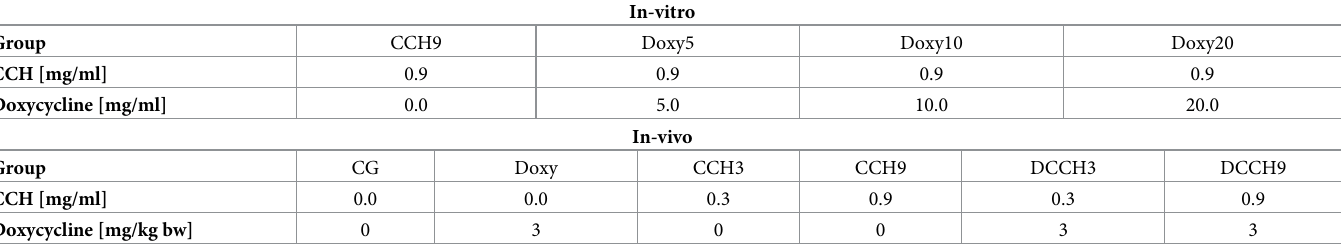
Table 1. Study groups of in-vitro and in-vivo experiments. In-vitro: Group names and corresponding concentrations of CCH and doxycycline for tissue incubation. In- vivo: Group names and corresponding oral doxycycline doses for administration on day 118 and 119 after implant insertion and corresponding CCH concentrations for injection into the implant pocket on day